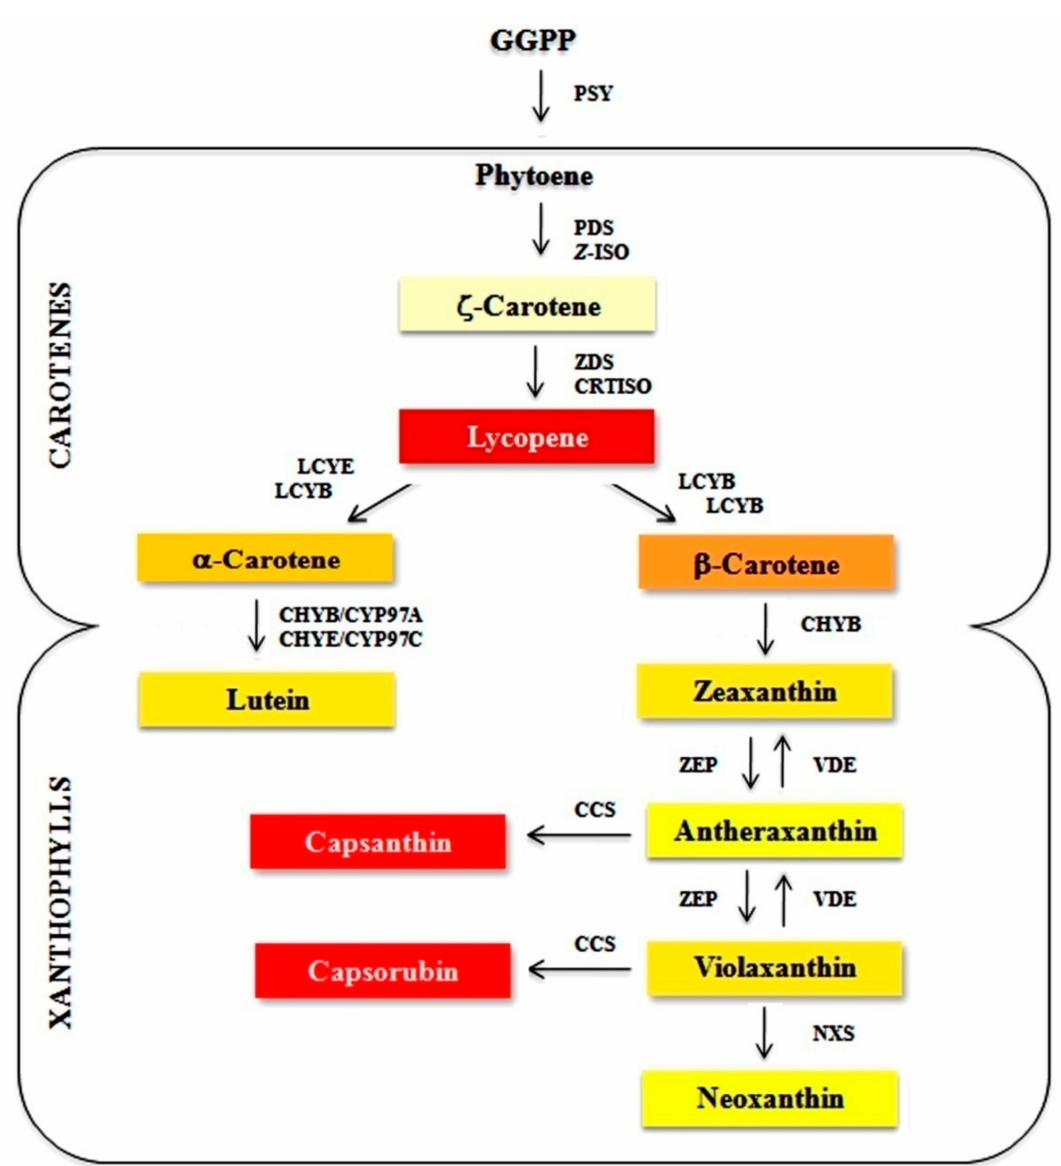
Figure 1. Schematic illustration of carotenoid biosynthesis in plants. GGPP, geranylgeranyl diphosphate; PSY, phytoene synthase; PDS, phytoene desaturase; Z-ISO, 15-cis- ζ -carotene isomerase; ZDS, ζ -carotene desaturase; CRTISO, carotenoid isomerase; LCYB, lycopene β -ring cyclase; LCYE, lycopene ε -ring cyclase; CHYB, β -ring hydroxylase; CHYE, ε -ring hydroxylase; CHYB/CYP97A, cytochrome P450-type β -ring hydroxylase; CHYE/CYP97C, cytochrome P450-type ε -ring hydroxylase; ZEP, zeaxanthin epoxidase; VDE, violaxanthin de-epoxidase; NXS, neoxanthin synthase; CCS, capsan- thin/capsorubin